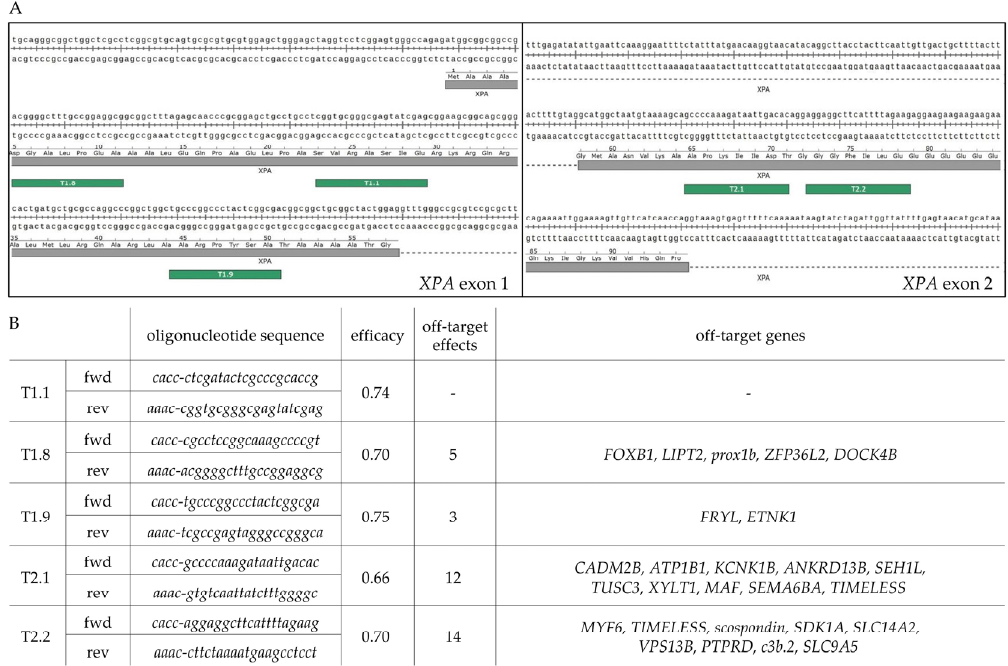
Figure 1. Selection process of sgRNAs. ( A ) Overview of chosen XPA exon 1 and 2 target sequences (represented by green bars) as suggested by CRISPR/Cas9 target online predictor (CCTop, University of Heidelberg) and their location within the exonic sequences modified from SnapGene Viewer, GSL Biotech LLC, San Diego, CA. Coding region represented by grey bars. ( B ) Characterization of the five final sgRNAs. Target sequences with prespecified off-target effects directly related to DNA repair and cell survival were excluded. The selection was based on high efficacy and/or low number of off-target effects. sgRNA nomenclature included their targeted exon followed by a consecutive number. Oligonucleotide fwd- and rev- sequences are shown including their overhangs, CACC and AAAC, for cloning into the BbsI cleavage site in PX459. Fwd, forward (5 ′ –3 ′ ); Rev, reverse (3 ′ –5 ′ ); sgRNA, single-guide RNA.